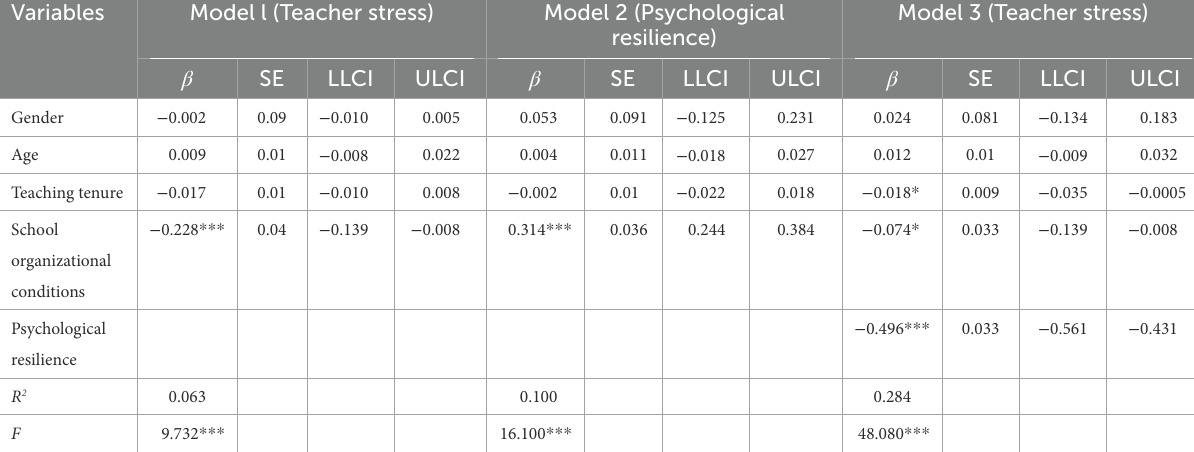
TABLE 2 The mediation effect of school organizational conditions on teacher stress via resilience.